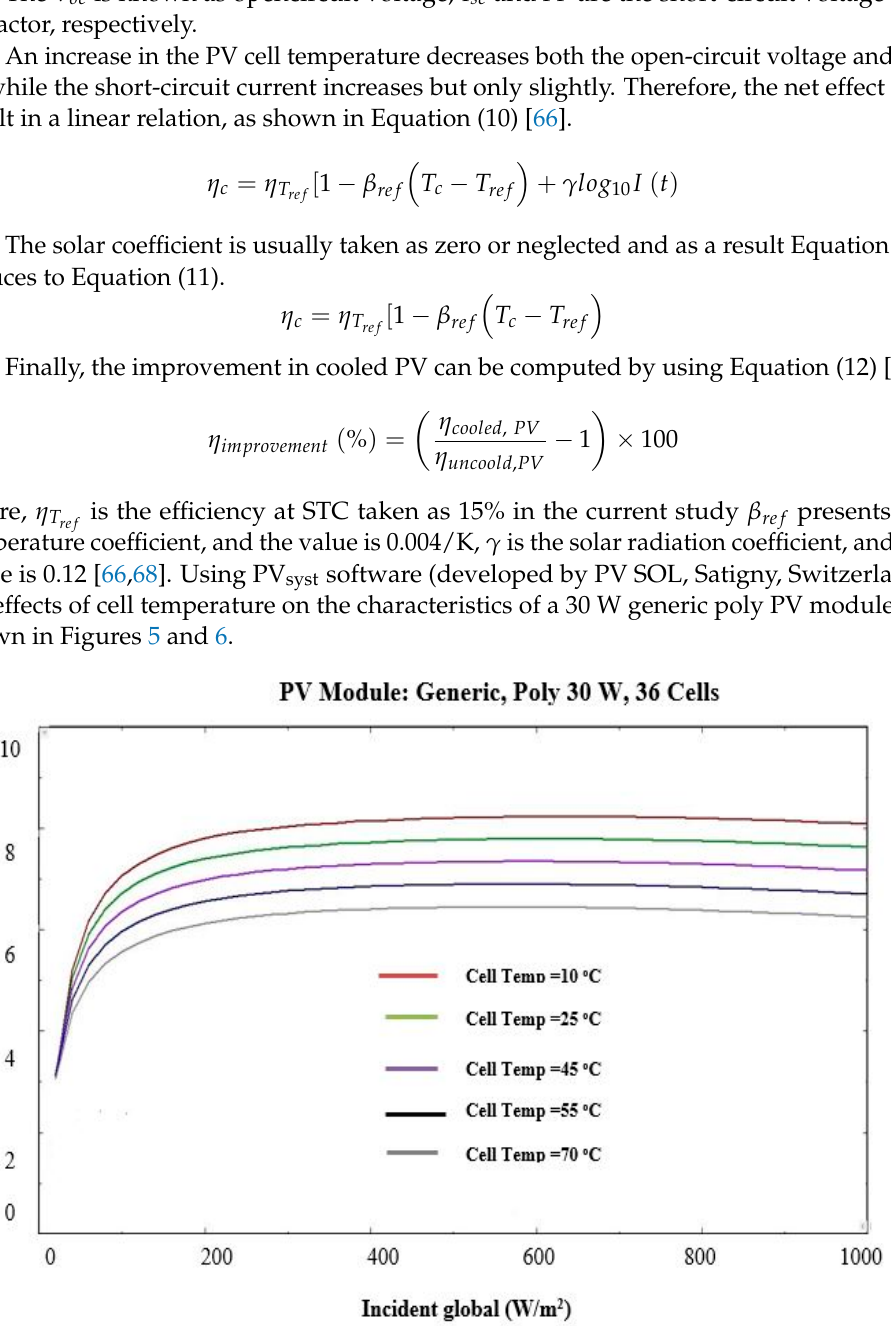
Figure 6. Effect of incident radiation on the P-V plot at 45 °C cell temperature (obtained from PVsyst software).